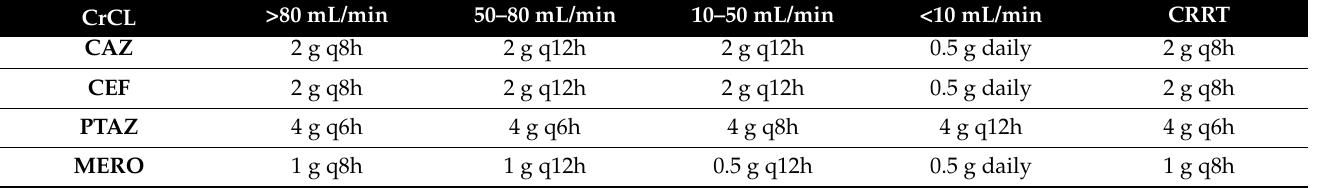
Table 1. Usual daily doses of antibiotics and dose adaption on renal function. CrCl = creatinine clearance; CAZ = ceftazidime; CEF = cefepime; PTAZ = piperacillin-tazobactam; MERO = meropenem; CRRT = continuous renal replacement therapy.